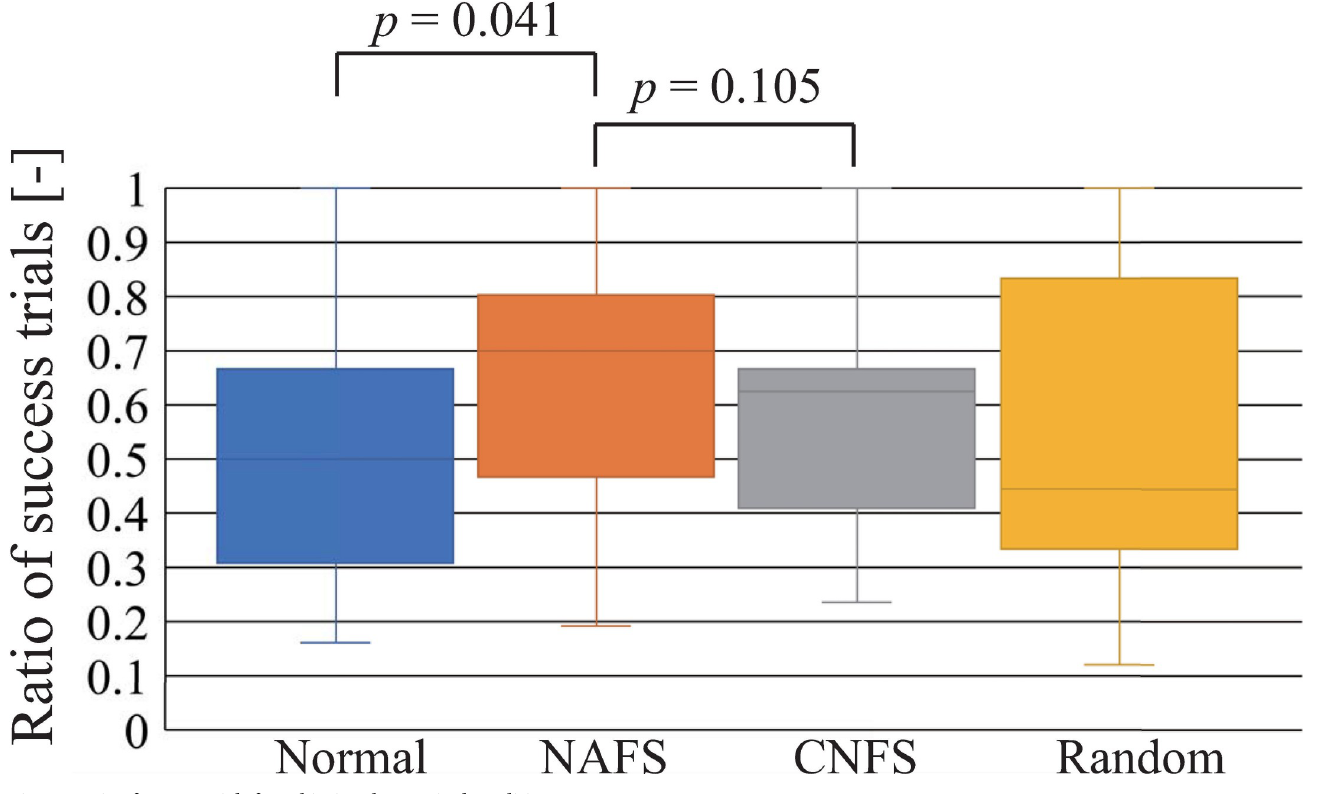
Fig 11. Ratio of success trials for achieving the terminal